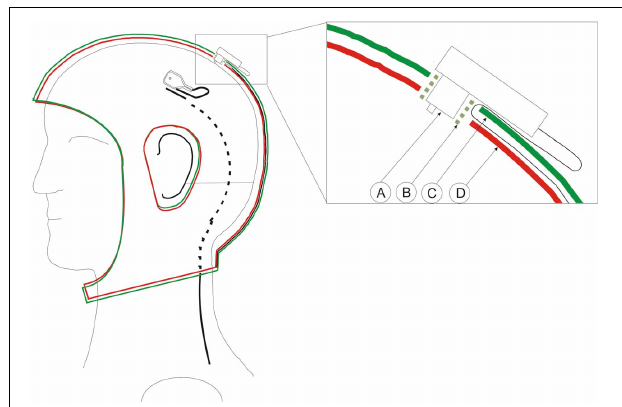
FIGURE 2 | Schematics of the adapted double layered actiCap. Left: Cap with an electrode whose wire enters into the cap layer. The black cable is on the surface and it is depicted as a dashed line as it enters into the first layer of the cap. It leaves the cap at the bottom. Right: Close-up of a transverse view of an electrode inserted in the cap. A, Electrode; B, Plastic electrode holder; C, Upper cap layer. D, Lower cap layer. The green plastic electrode holder helps to fix both layers and the electrode. The cable passes trough the first layer to be fixed between both layers.